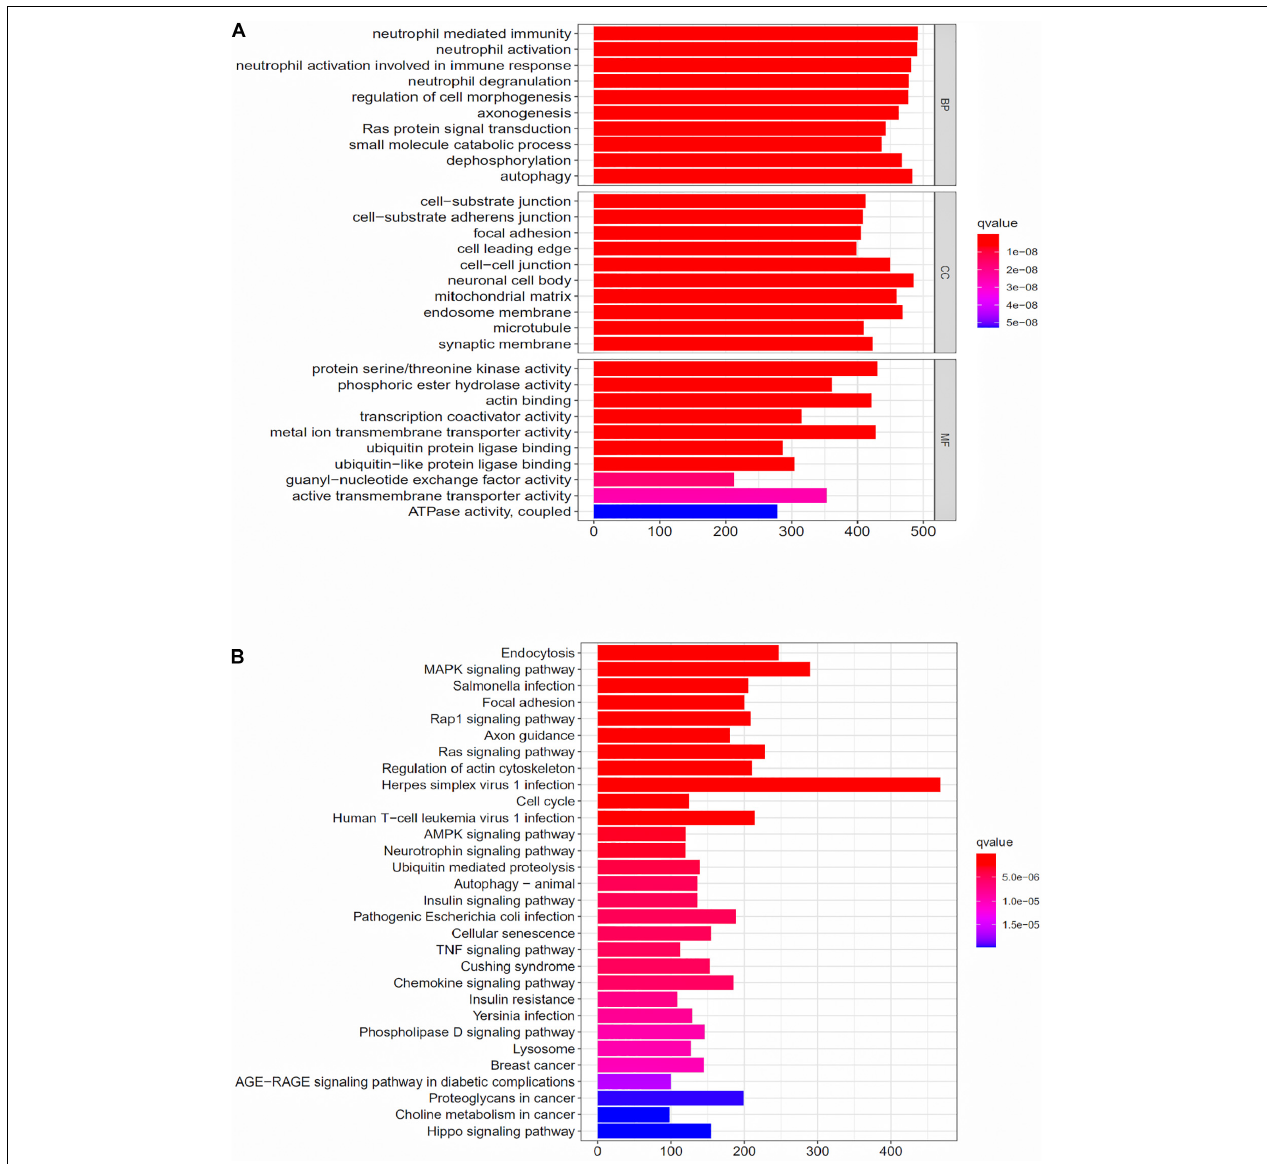
FIGURE 5 | GO enrichment analysis and KEGG enrichment analysis for the differentially expressed genes between the high-risk group and the low-risk group. (A) GO enrichment analysis for the differentially expressed genes between the high-risk group and the low-risk group. (B) KEGG enrichment analysis for the differentially expressed genes between the high-risk group and the low-risk